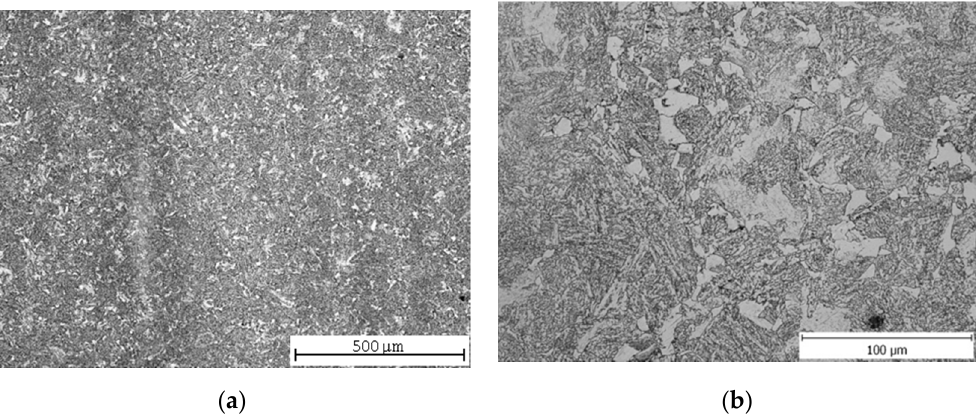
Figure 9. 30CrV9 steel microstructures after normalization annealing: ( a ) central part; ( b ) detail. Soft annealing led to a partial spheroidization of the pearlite (Figure 10a). Due to presence of Cr and V carbides (the steel is alloyed with chromium and vanadium), spheroidization was slowed down [38]. Ferrite was precipitated along the grain boundaries (Figure 9b).